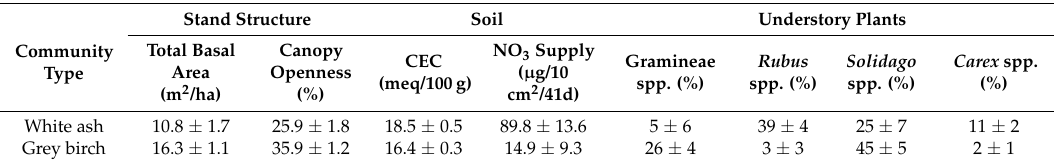
Table 2. Mean value ( ± standard error) of selected environmental variables in the two forest community types (N = 8 blocks in the White ash community type and N = 17 blocks in the Grey birch-balsam poplar-elm community type). All means are statistically different between community types at the α = 0.05 level following Student’s t -test. d =